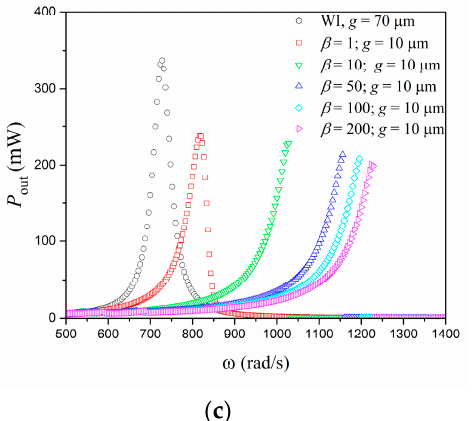
Figure 6. Average power versus forcing frequency using g = 70 µ m (without impact) and incorporating impacts with different values of β : ( a ) g = 50 µ m, ( b ) g = 30 µ m, and ( c ) g = 10 µ m.